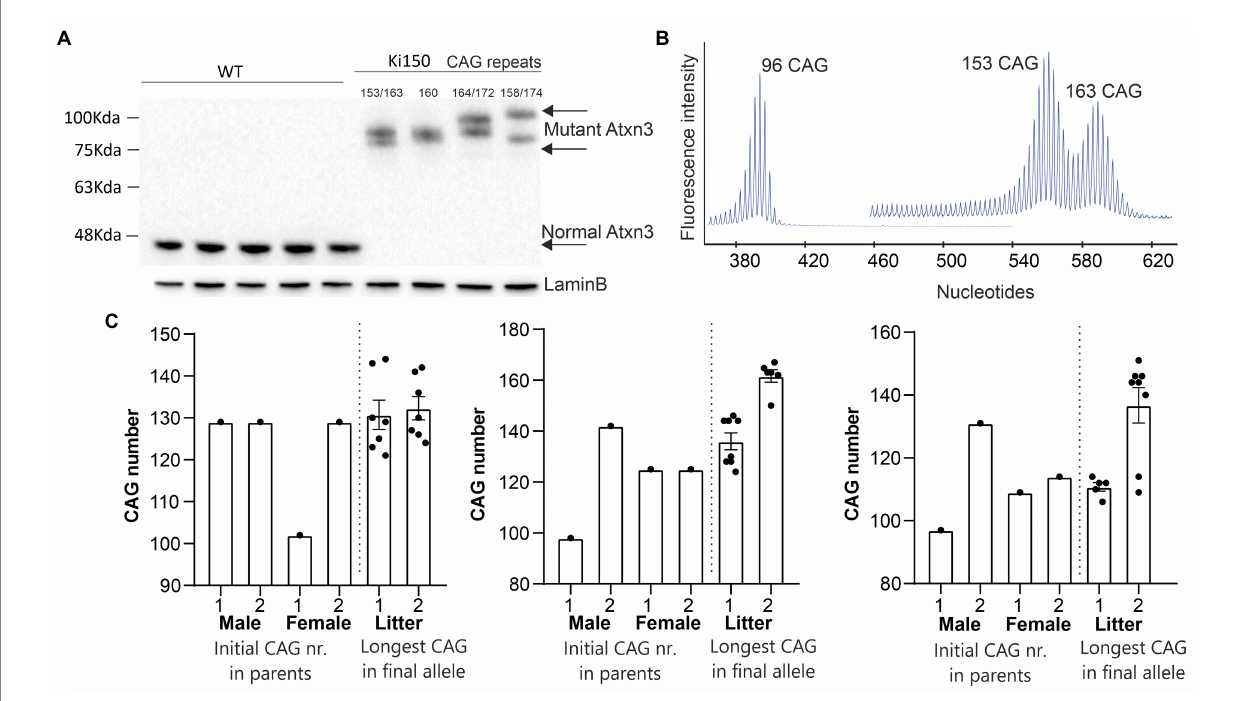
FIGURE 1 A new Ki150 mouse model expressing ataxin-3 with a large polyQ domain. Generation of the preclinical-type Ki150 mouse model with enhanced phenotype. (A) Homozygous Ki150 brain contains the polyQ-expanded ataxin-3 which reaches approximately 100 kDa in weight on immunoblot. The number of glutamines in ataxin-3 proteins is indicated in Ki150. LaminB was used as a loading control. (B) Representative examples of increasing CAG number in alleles of parents vs. offspring in humanized ATXN3 gene between Ki91 and Ki150 mouse models. (C) Analysis of the CAG number (96 and 153–163 CAGs) in alleles visible on peeks representing the capillary electrophoresis of the DNA PCR products. Male and female denote parent animals containing the indicated CAG number in ATXN3 of parents’ allele. The “litter” denote the individual offspring mice with the CAG number of the final longest